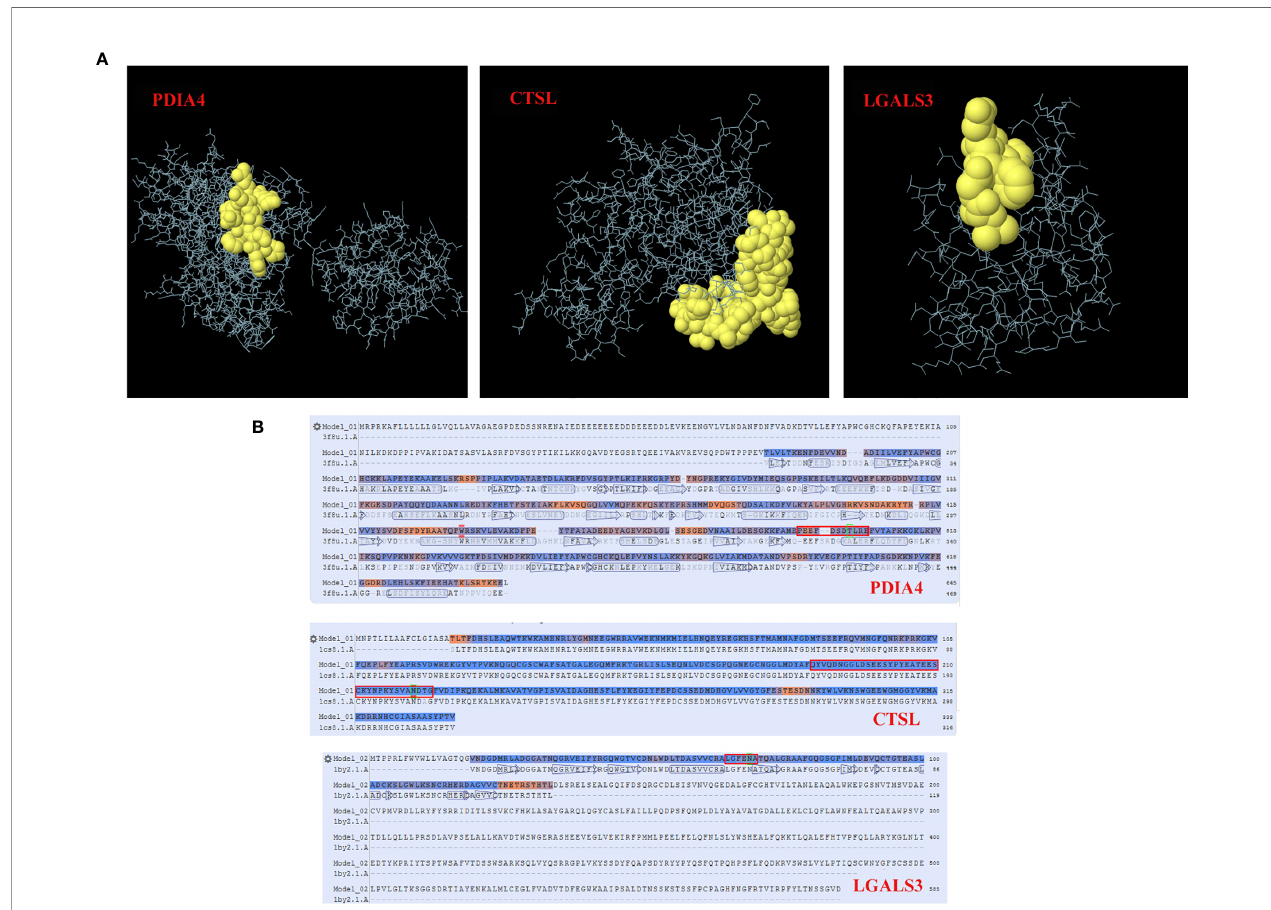
FIGURE 4 | Conformational B cell epitopes of speci fi c glycosylated peptides. In the ball-and-stick models (A) , yellow balls are the residues of the predicted epitopes, and white sticks are the structures of nonepitopes and core residues. In the model-template alignment (B) , each epitope is shown with predicted residues and residue positions: P13667, PEEFDSDTLRE (490-500); P07711, QYVQDNGGLDSEESYPYEATEESCKYNPKYSVANDTG (188-224); and Q08380, LGFENA (65- 70). The amino acid in the green frame is the glycosylation